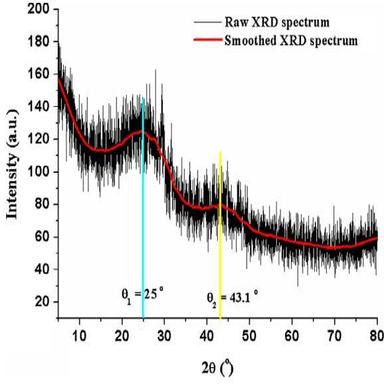
XRD pattern of carbonized Poplar fluff sample at 850 °C.